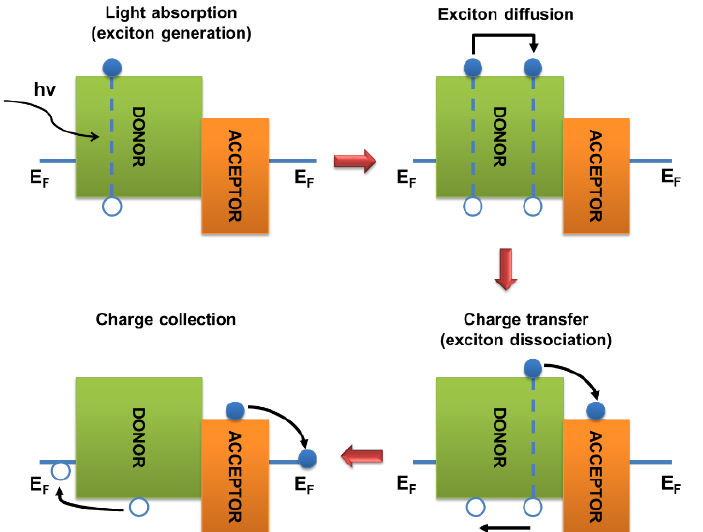
Figure 4. Mechanism of light energy conversion in organic solar cells using light absorption by the donor component as an example.